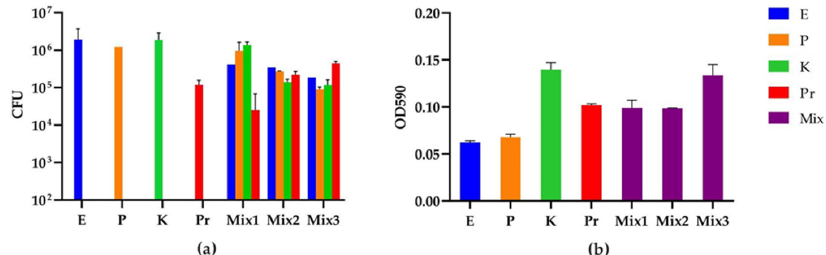
Figure 3. CFU and biomass of the mono ‐ and multispecies biofilms from different strain inoculation ratios of E. coli (E), P. aeruginosa (P), K. oxytoca (K) and P. mirabilis (Pr): ( a ) CFU